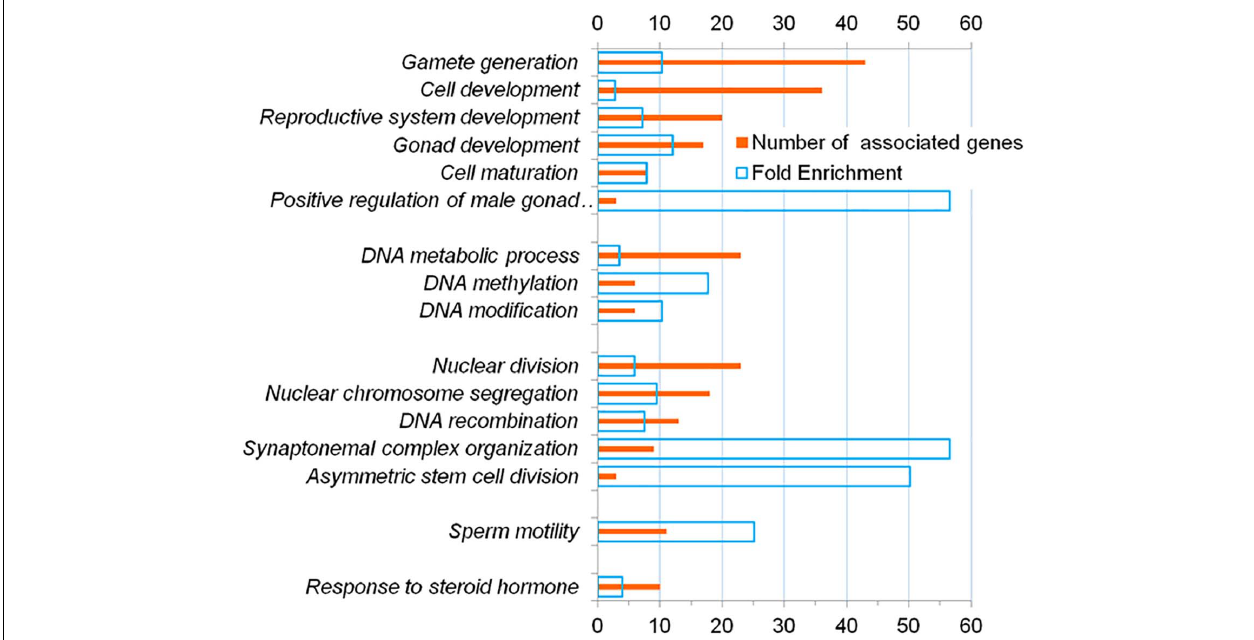
FIGURE 2 | Representative terms from the Gene Ontology database which, according to DAVID, are overrepresented (FDR < 5 * 10 − 2 ) in the annotations of genes from the catalog HGAPat.